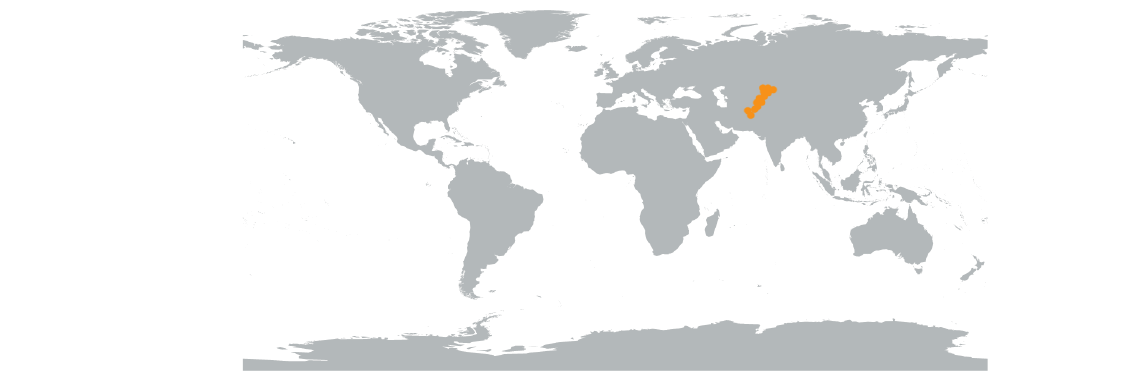
Fig. 15. Distribution of Malus kirghisorum Al.Fed. & Fed.